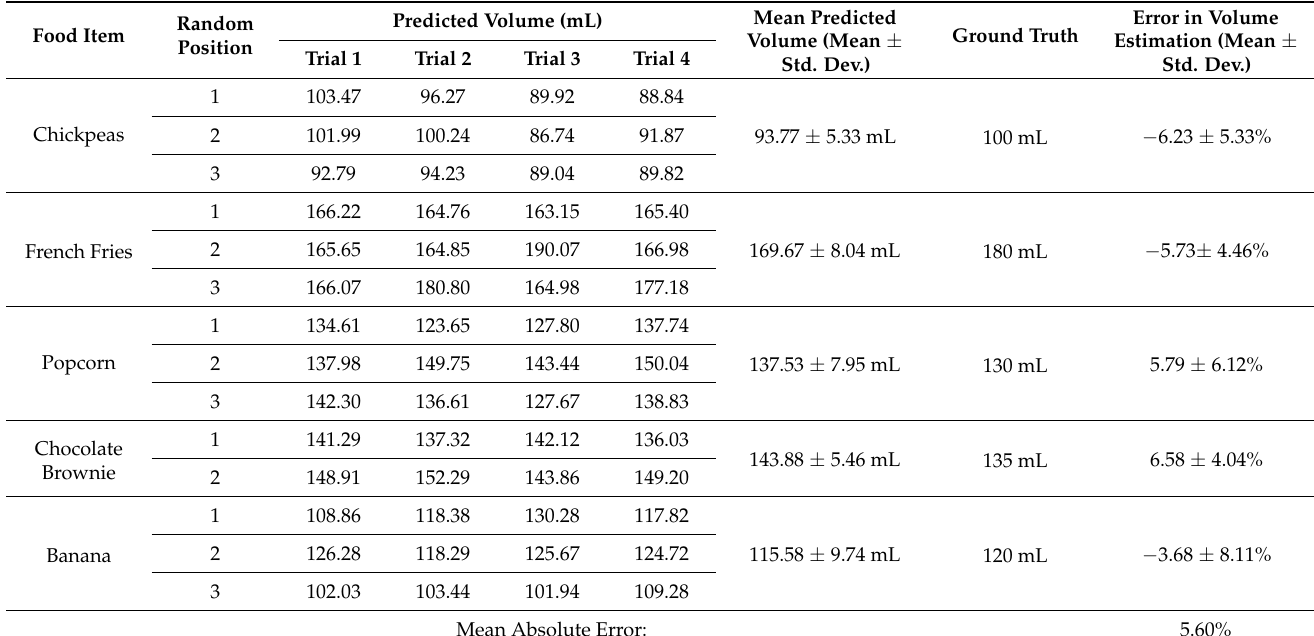
Table 4. Errors in volume estimation using